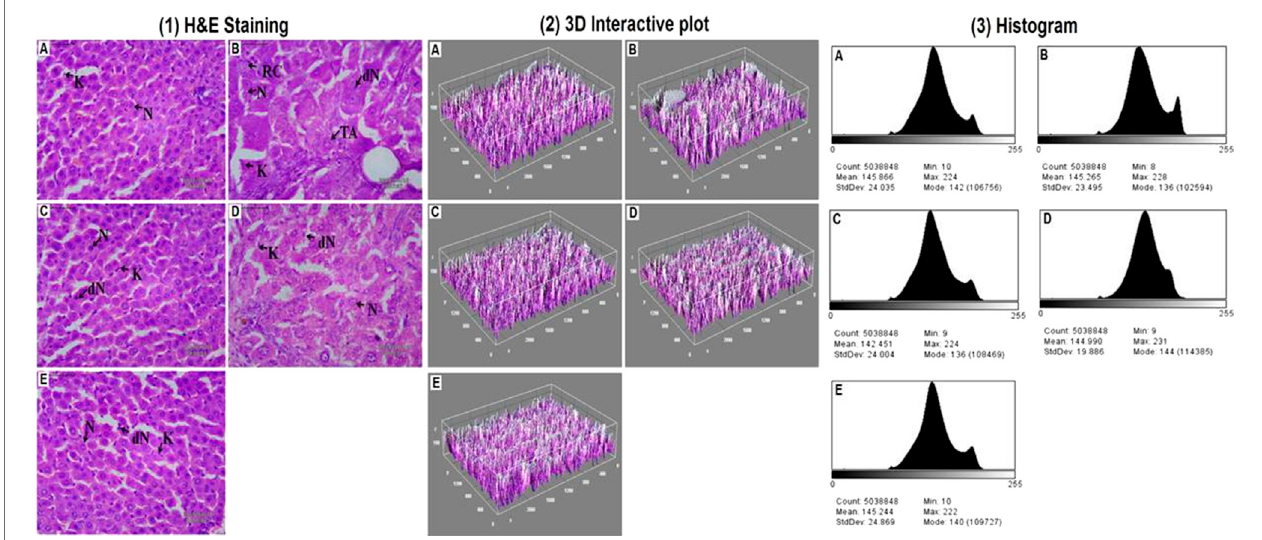
FIGURE 2 | Hepatic pathological changes in DEN-induced rats. [1] Histopathological changes (40X, Scale bar 50 μ m) and the studied groups are A: Normal Control,B:CarcinogenControl,C:PositiveControl,D:DI(100 mg/kg)andE:DI(200 mg/kg).Theabbreviationsusedarenormalnucleus(N),degeneratednucleus(dN), ruptured hepatic cells (RC), and tumor anaplastic cells (TA). 3D image reconstruction and software-based analysis dataset of constructs representing the score was done byusing ImageJ (NIH) software bythresh holding ofstainedzones ofH&Eimages followed bypixelvsintensitydetermination bythe[2]3Dinteractivesurface plot and [3] the histogram